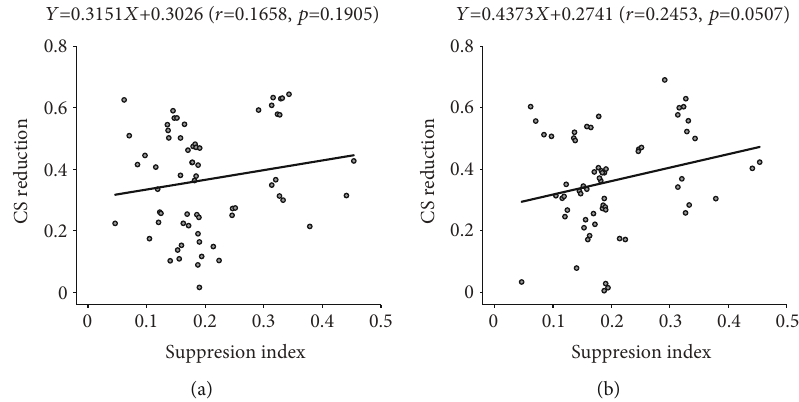
Figure 6: Scatter plots showing the correlation between the reduction amplitude (%) in the contrast sensitivity (CS) and surround suppression strength of all NSS neurons at performance criterion 70.7% (a) and 79.4% 3.3. Mechanisms of Surround Suppression E ff ect on Neuronal Contrast Sensitivity. To identify the mechanisms of surround suppression e ff ect on the CS of di ff erent neuronal popula- tions, we fi rst compared the threshold contrast (TC) versus external noise contrast (TvC) functions from neurons with and without surround stimuli at di ff erent SFs (Figure 8).